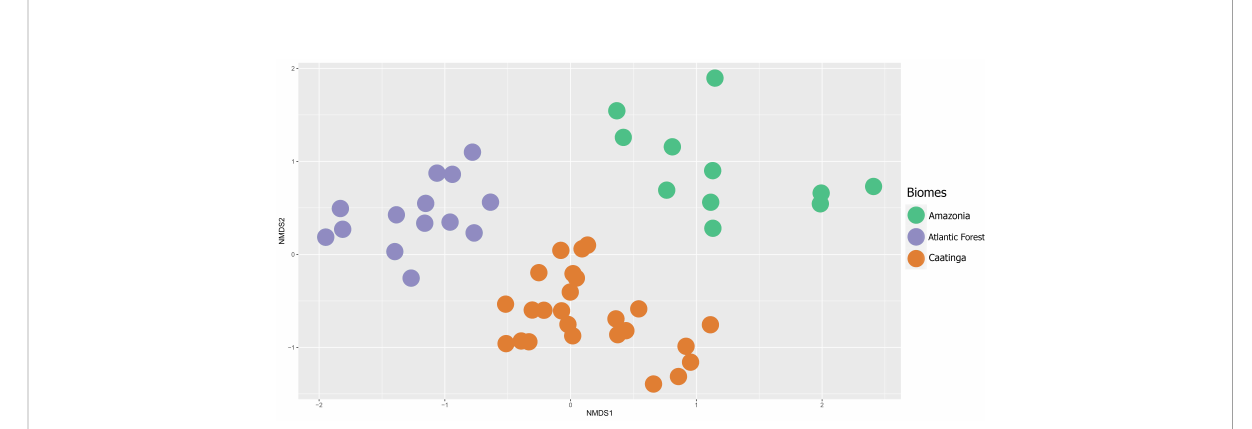
FIGURE 3 Ordination of 50 inselbergs in South America inferred from nonmetric multidimensional scaling of their species composition. Colors indicate the a priori classi fi cation into the main Neotropical biomes. Orange = Caatinga; Mauve = Atlantic Forest; Green = Amazon.